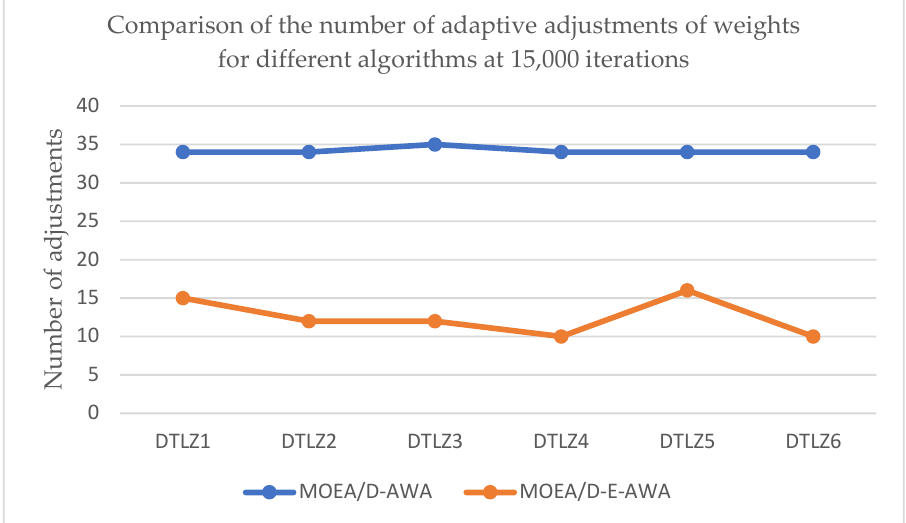
Figure 2. Comparison of weight adaptive adjustment times of M-E-AWA and MOEA/D-AWA algorithms when the maximum number of iterations is 10,000.